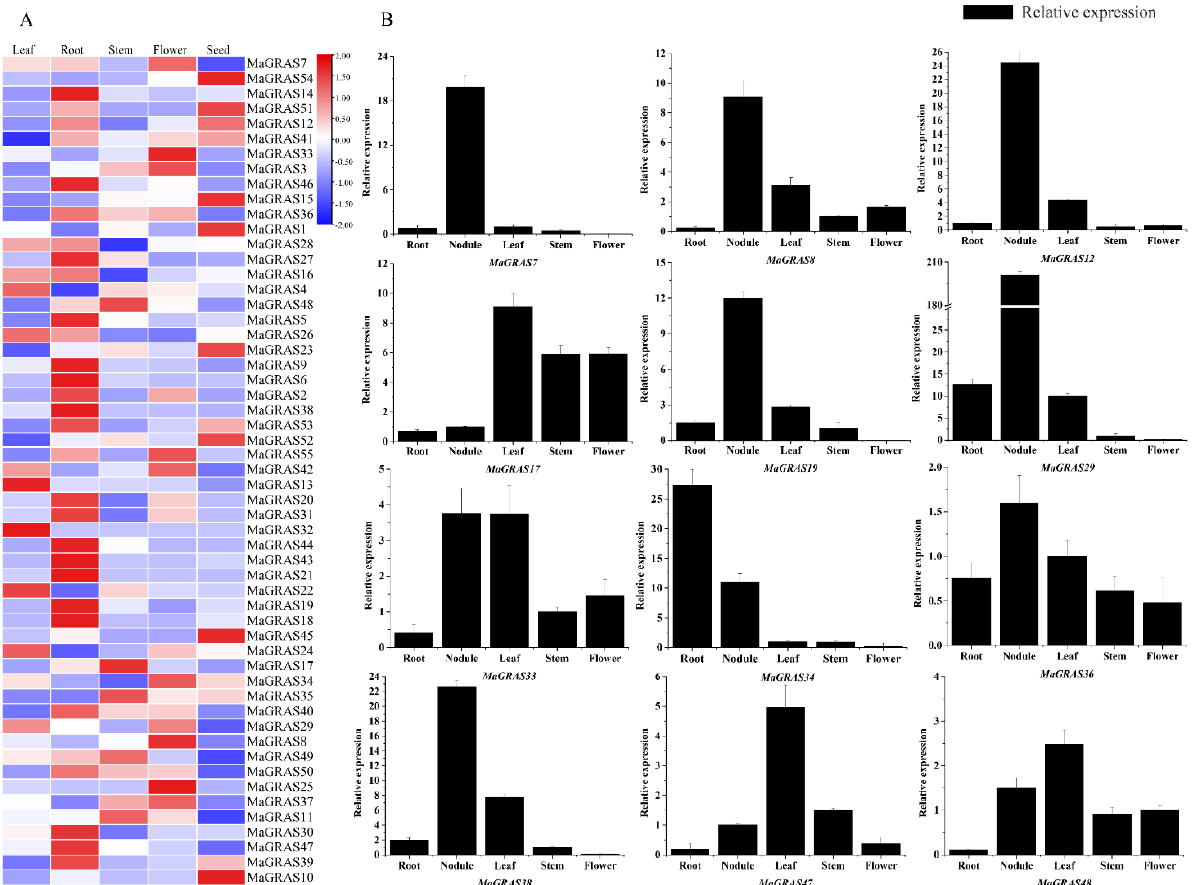
Figure 6. Expression analysis of the MaGRAS genes in different tissues: ( A ) a Heat map of all MaGRAS genes in different tissues based on transcriptome datasets, the expression values (FPKM) were normalized; ( B ) expression analysis of the MaGRAS genes in different tissues using qRT–PCR, the values shown are the means ± standard deviation of three replicates.